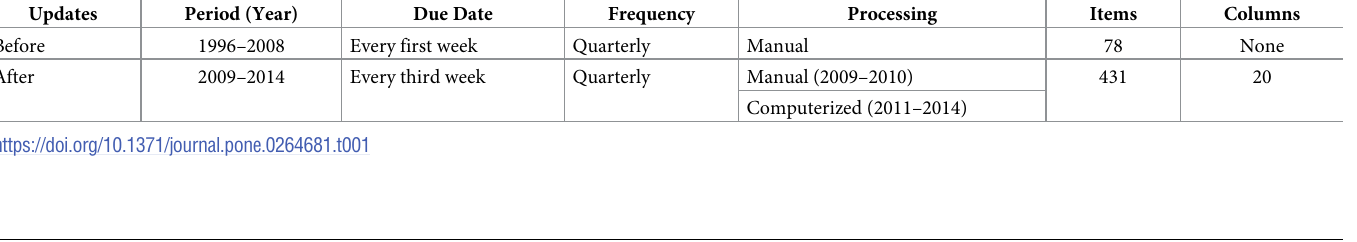
Table 1. Characteristics of FHSIS before and after the update.